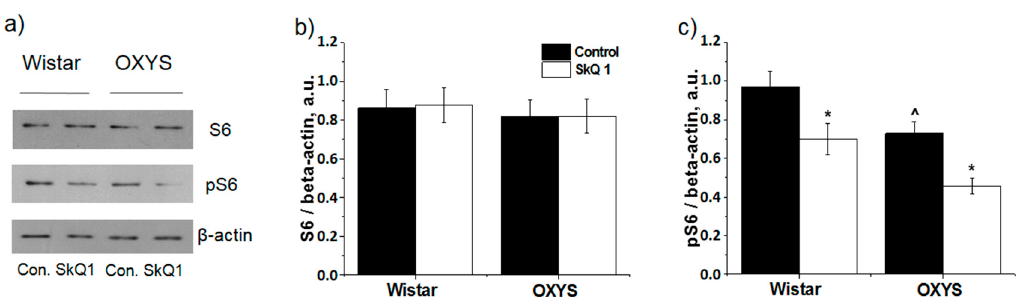
Figure 4. Effects of treatment with SkQ1 (250 nmol/kg per day from 1.5 to 22 months of age) on the protein levels of ribosomal protein S6 and p-S6 in the retina of OXYS and Wistar rats. The levels of S6 and p-S6 in the retina of OXYS and Wistar rats, according to western blot analysis ( a ). The relative quantity of proteins S6 ( b ) and p-S6 ( c ) was calculated with β -actin as the control (M ± SE, n = 5). ^: Statistically significant differences between the strains of the same age; *the effect of SkQ1 (p < 0.05).